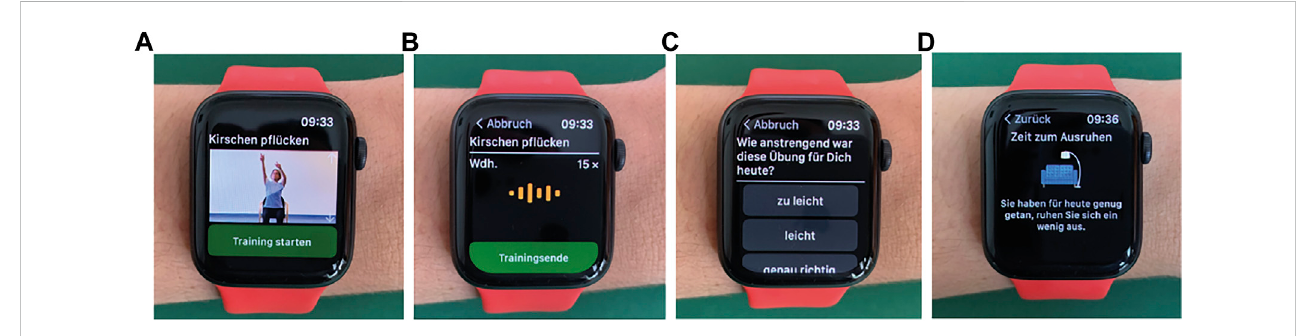
FIGURE 2 Programming of the suMus App: (A) Tailored exercise plans designed by the therapists are visualized in the App; (B) During the training, sensors register acceleration and rotation rate; (C) After the exercise, the patient is asked to provide feedbacks; (D) After completing the whole exercise plan, patients are informed through a visual input that rest is